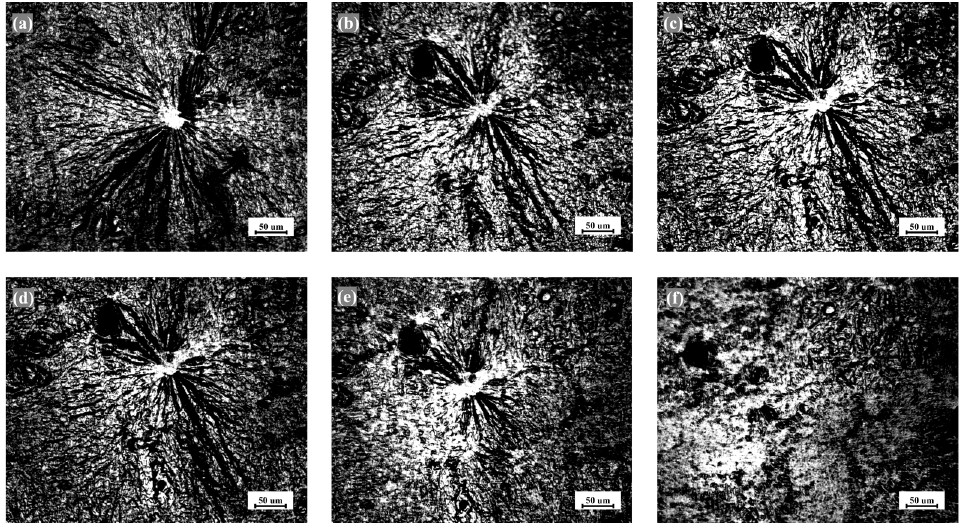
Figure 6. In-situ real-time observation of structural changes in oxide film of AA6111 alloy melt from 973 K to 1173 K: ( a ) 973 K, ( b ) 1023 K, ( c ) 1053 K, ( d ) 1073 K, ( e ) 1123 K, ( f ) 1173 K.